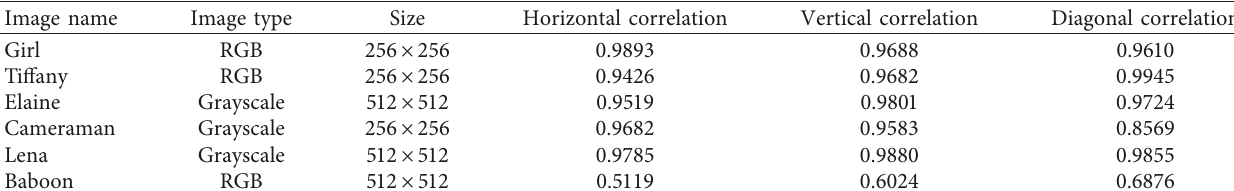
Table 2: Correlation of adjacent pixels for a given image from SIBI